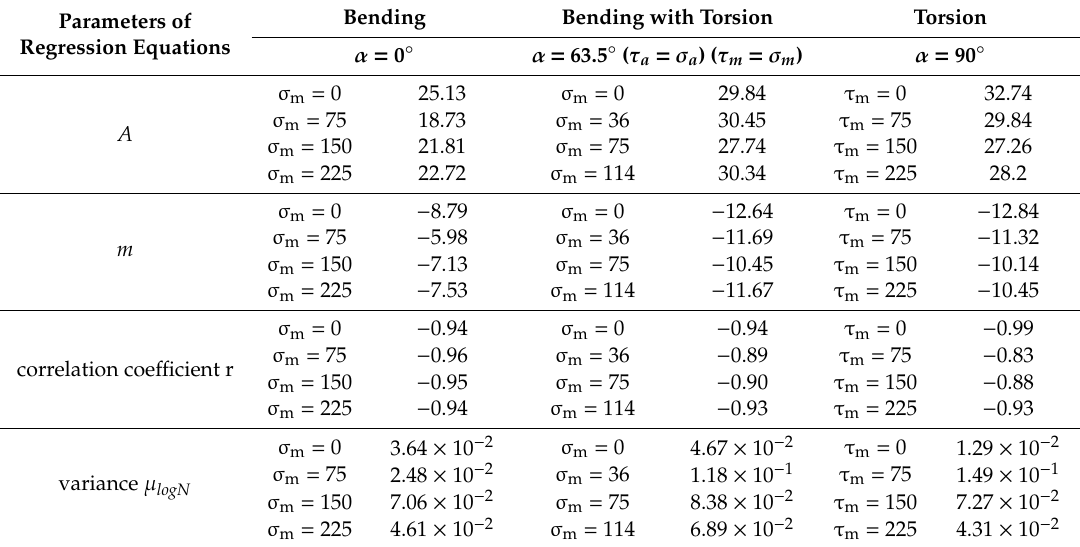
Table 4. Parameters of regression equations describing fatigue life of notched specimens.